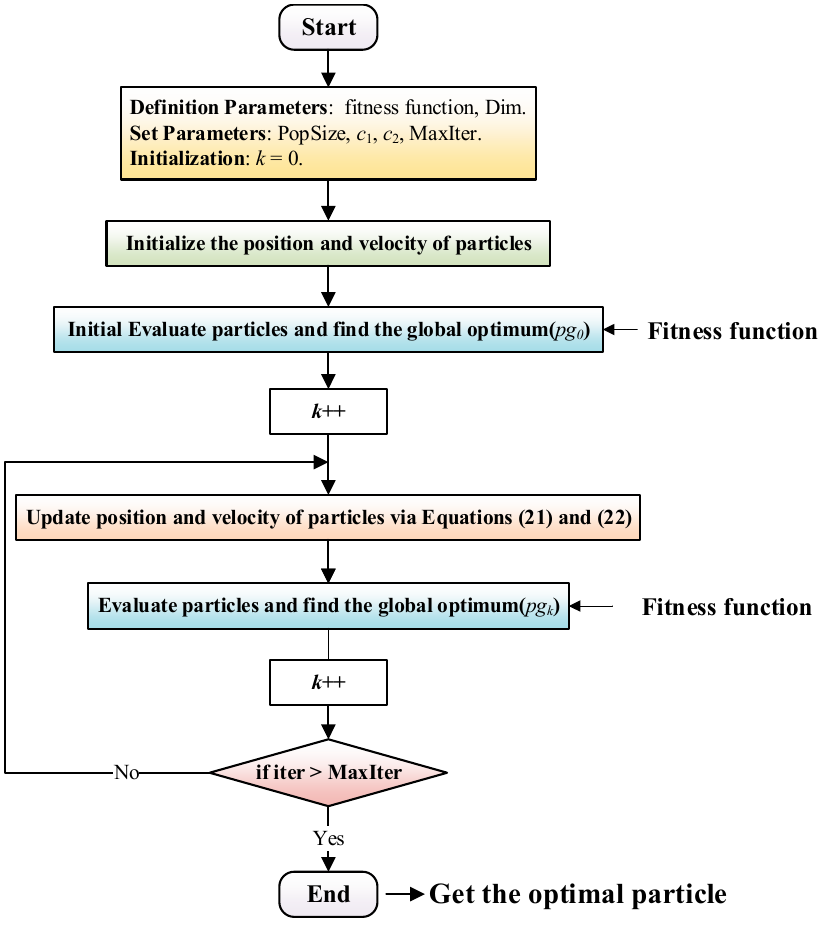
Figure 8. Principle of CPSO algorithm.